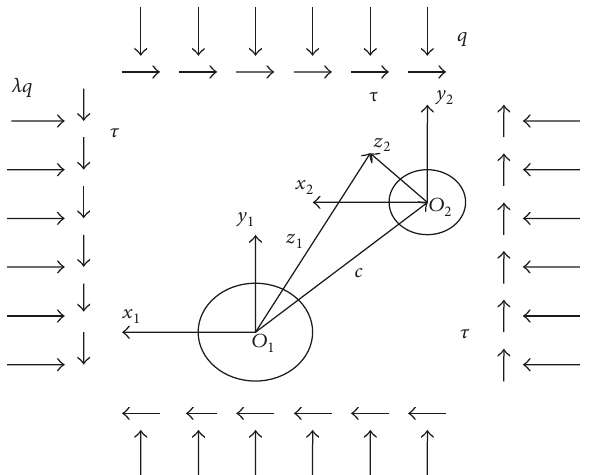
Figure 1: Mechanical model of double holes at optional position used in the Schwarz alternating